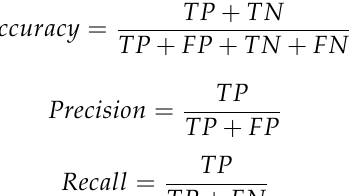
sents the number of normal network traffic incorrectly clustering to the attack cluster.